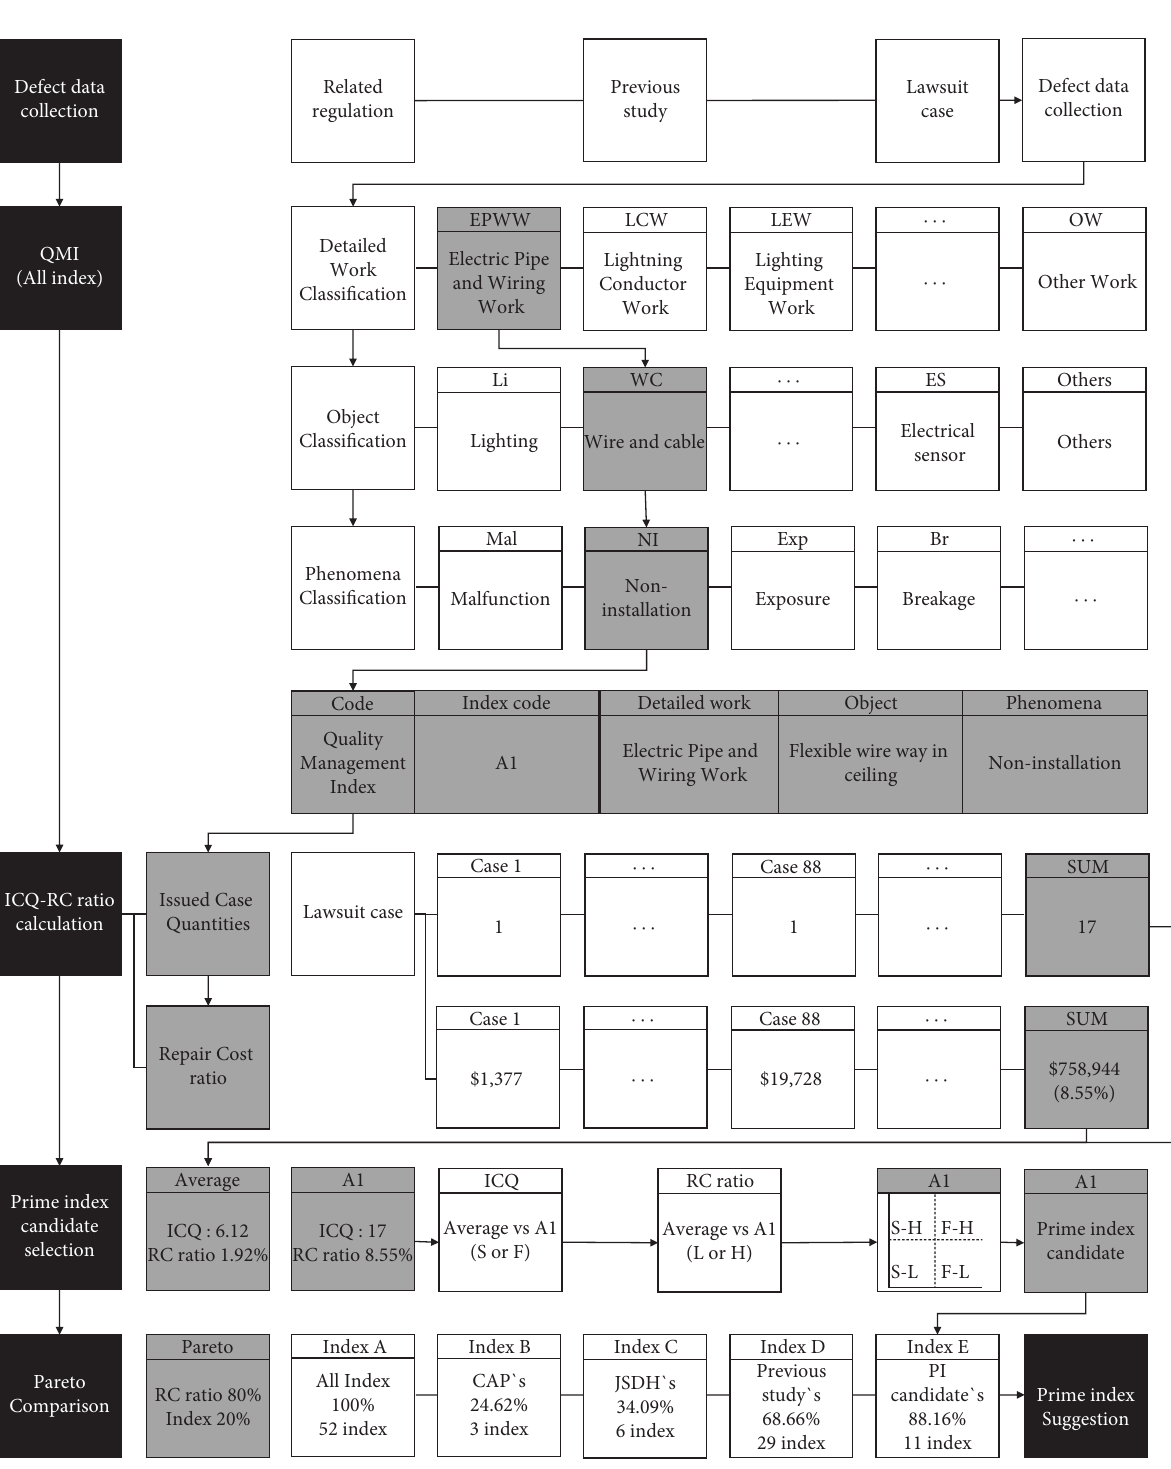
Figure 1: Research